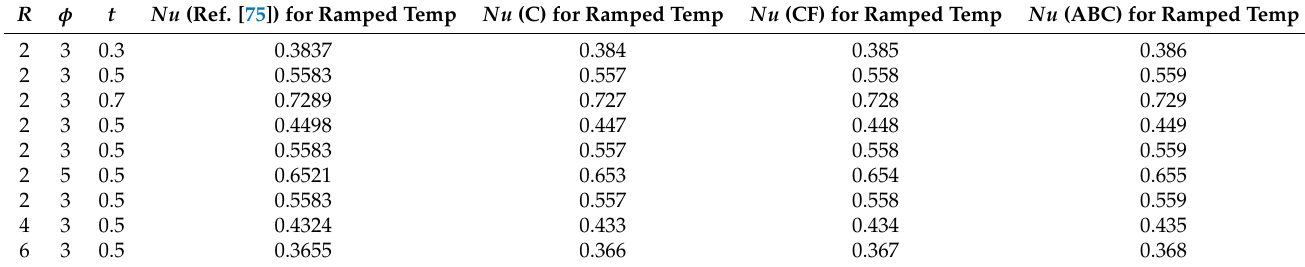
Table 1. Comparison of Nusselt number with ref. [72] at P r =